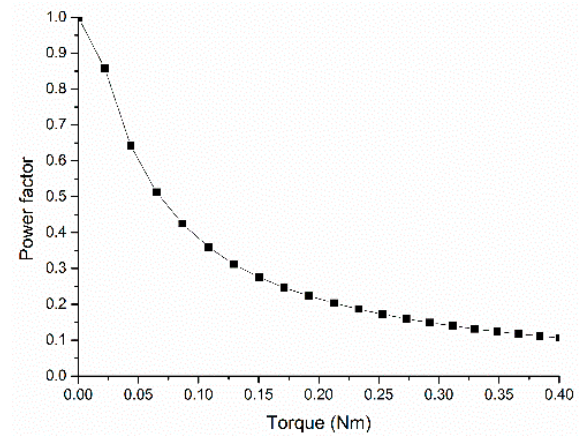
Figure 10. Power factor of FRCPM.